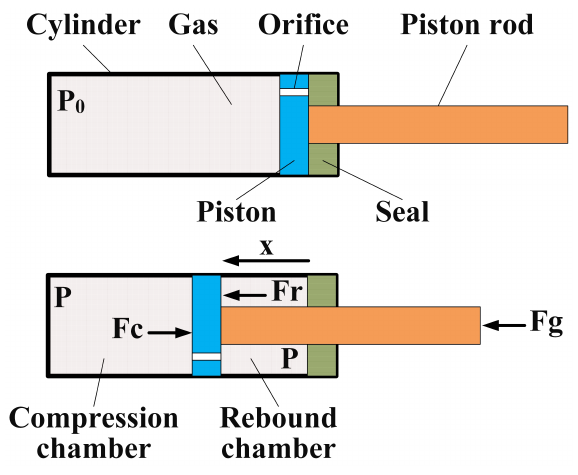
Figure 3. Schematics of gas